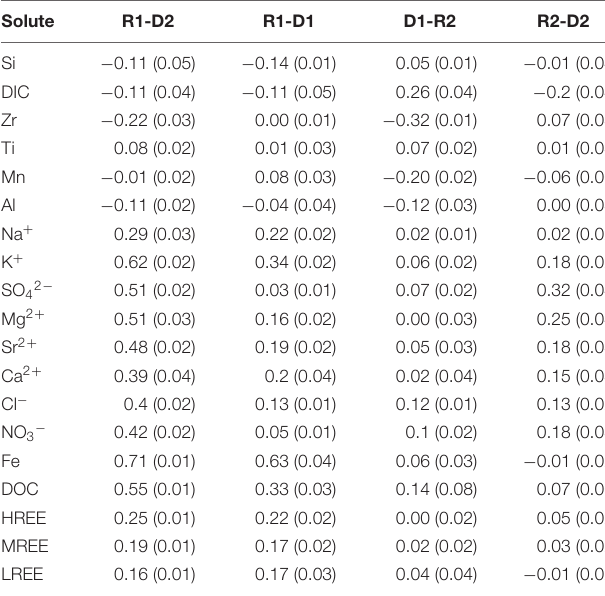
TABLE 3 | Summary of mean hysteresis indices (HI) calculated for pairs of hydrograph limbs.